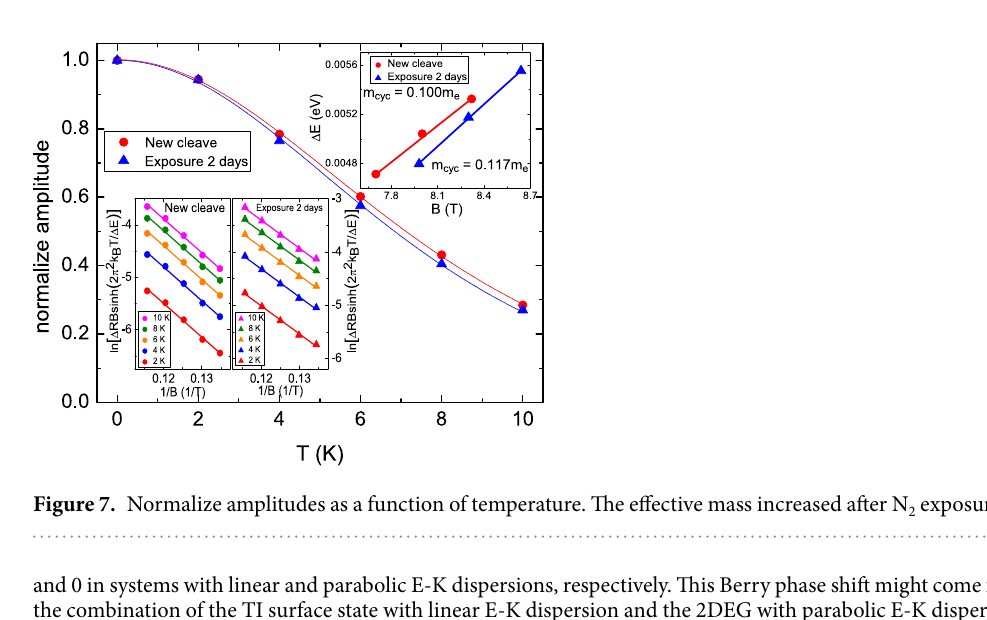
Figure 6. SdH oscillation as a function of inverse magnetic field and the related oscillation frequency. The oscillation amplitude increased by 30% after N 2 exposure, whereas the oscillation frequencies remained the same.